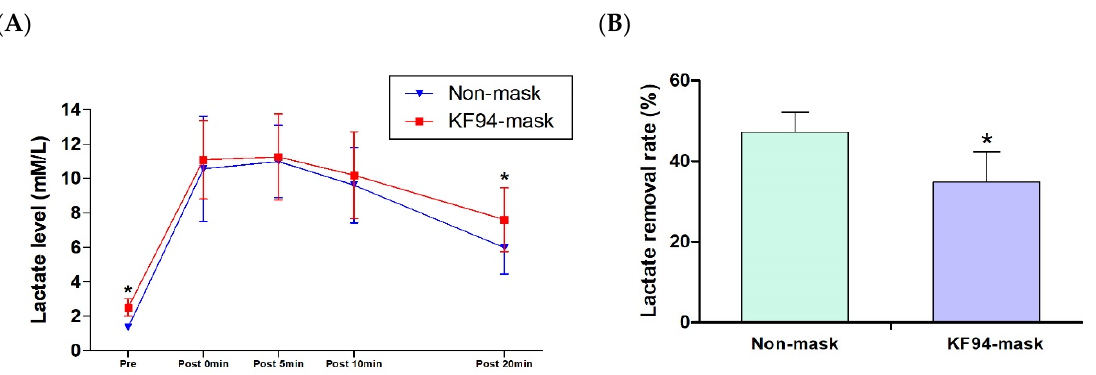
Figure 3. Maximum post-exercise lactate level change and lactate removal rate. ( A ) Lactate level; ( B ) lactate removal rate. * Indicates significant differences ( p < 0.05).